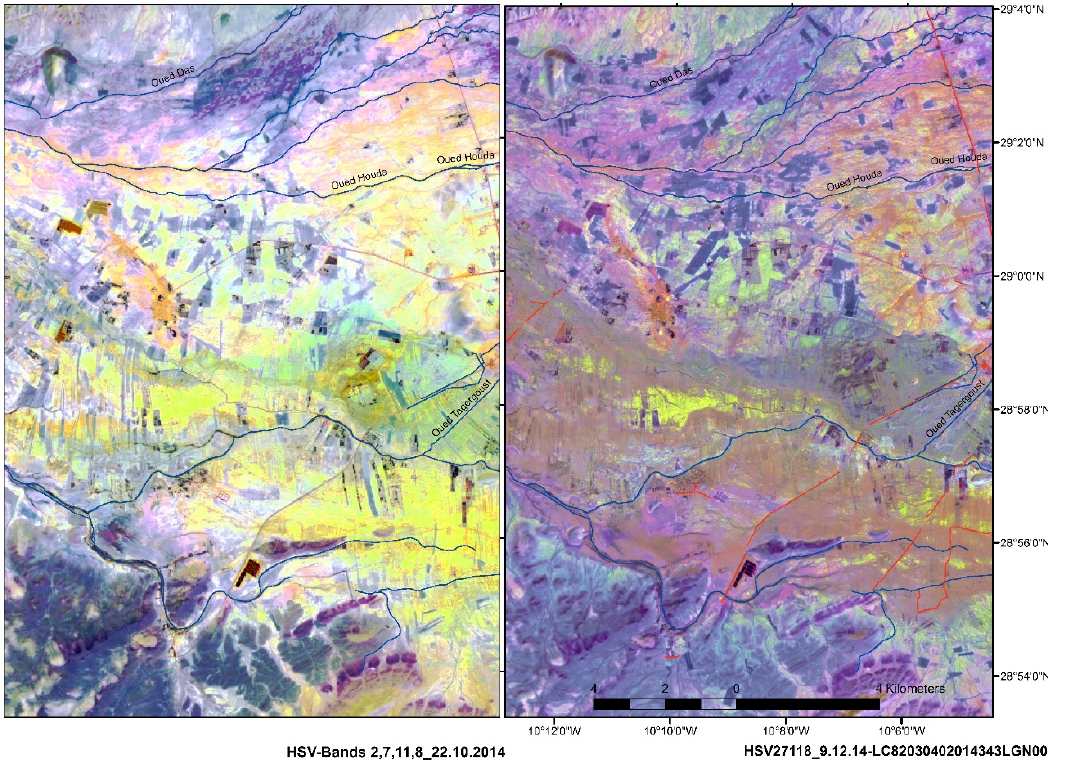
Figure 15. Road segments in flooding prone areas as visible on Landsat 8 scenes before (left image) and after the November 2014 flash floods (right image). The sedimentary deposits related to the flooding event are visible in brown colors.